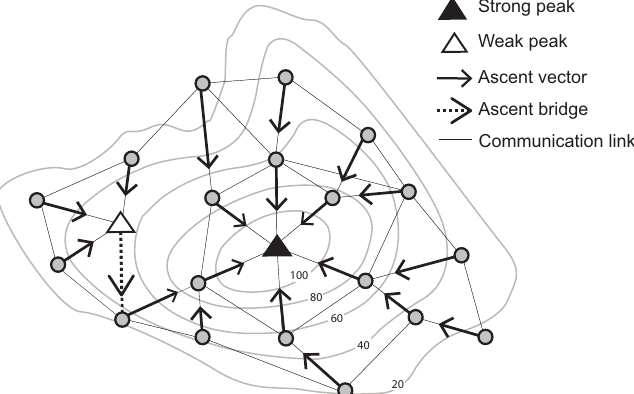
Figure 1. Identification of a strong and a weak peak, ascent vectors and an ascent bridge (Contour lines describe a scalar field showing the difference in elevation between consecutive contour lines. The sensed values can be estimated using a contour